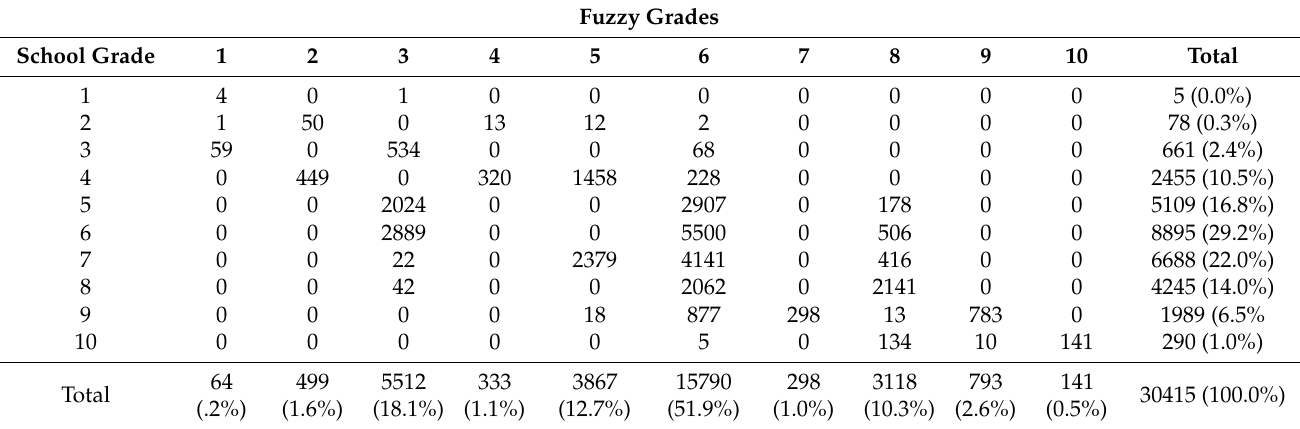
Table 13. The distribution of fuzzy grades among students with different school grades. Fuzzy Grades